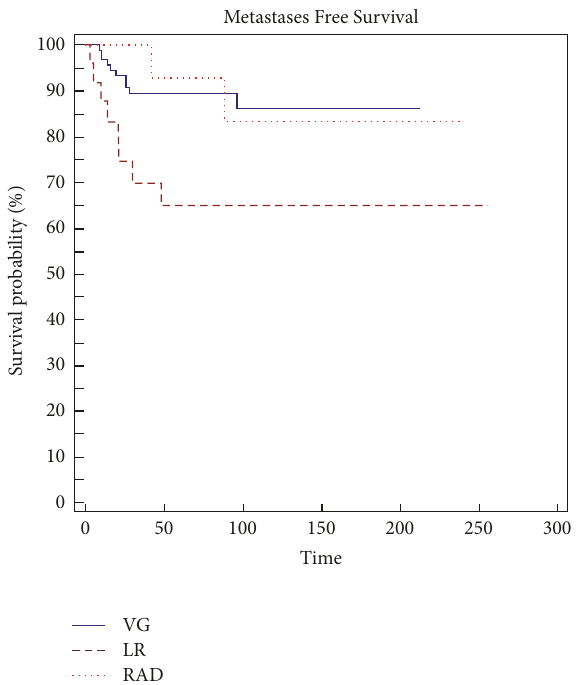
Figure 6: Presentation is a significant risk factor ( 𝑝 = 0,0243) in metastasis-free survival